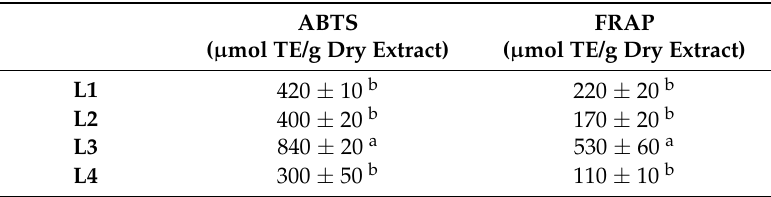
Table 2. Antioxidant activity in grape pomace (GP) extracts. Data are expressed as mean ± standard deviation ( n = 3). Means followed by the same letter within a column indicate no significant ( p > 0.05) difference among samples. Trolox-equivalent antioxidant capacity (TEAC) values: µ mol TE/g dry